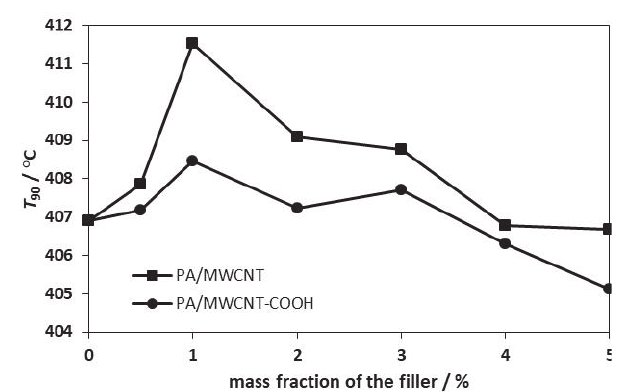
Fig. 7 – Influence of mass fraction of filler on onset tempera- ture (10 % of mass loss) for PA/MWCNT and PA/ MWCNT-COOH nanocomposites